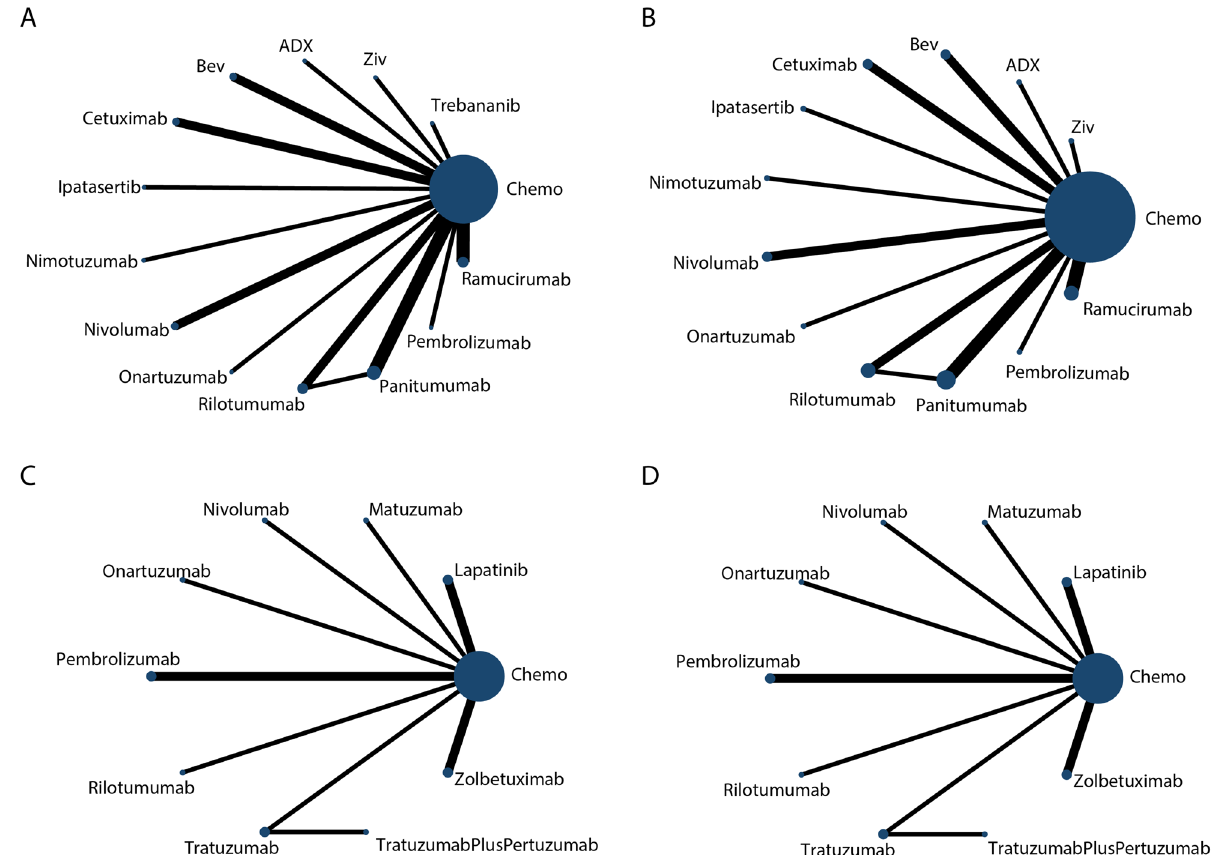
Figure 2. The network comparison plots of primary outcomes. ( A ) The network plots of OS in average group; ( B ) The network plots of PFS in average group; ( C ) The network plots of OS in specific positivity group; ( D ) The network plots of PFS in average group. Chemo: Chemotherapy; ADX: Andecaliximab; Ziv: Ziv-aflibercept; Bev: Bevacizumab. All regimens omitted with